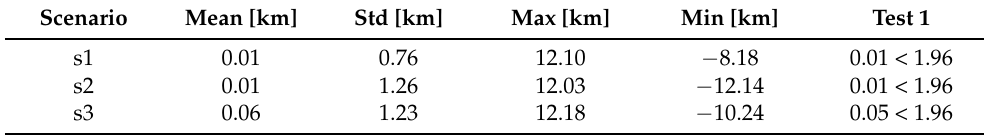
Figure 14. Results of test 3. On the abscissa the reference Moho depth, on the ordinate the statistics of the Moho differences for the corresponding subset of grid nodes. Blue line represents the mean of the differences, and the red ones represent the confidence interval depending on the standard deviation and the level of significance. Table 4. Statistics on the differences between the estimated and “true” Moho, (cid:98) D R − D true , for the three tested scenarios. The test 1 is implemented as in Equation (32) by replacing (cid:98) D O with D true .